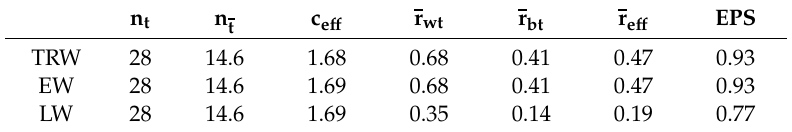
Table 1. Chronology statistics for total ring width (TRW) and earlywood (EW) and latewood (LW) indices 1 . n t n